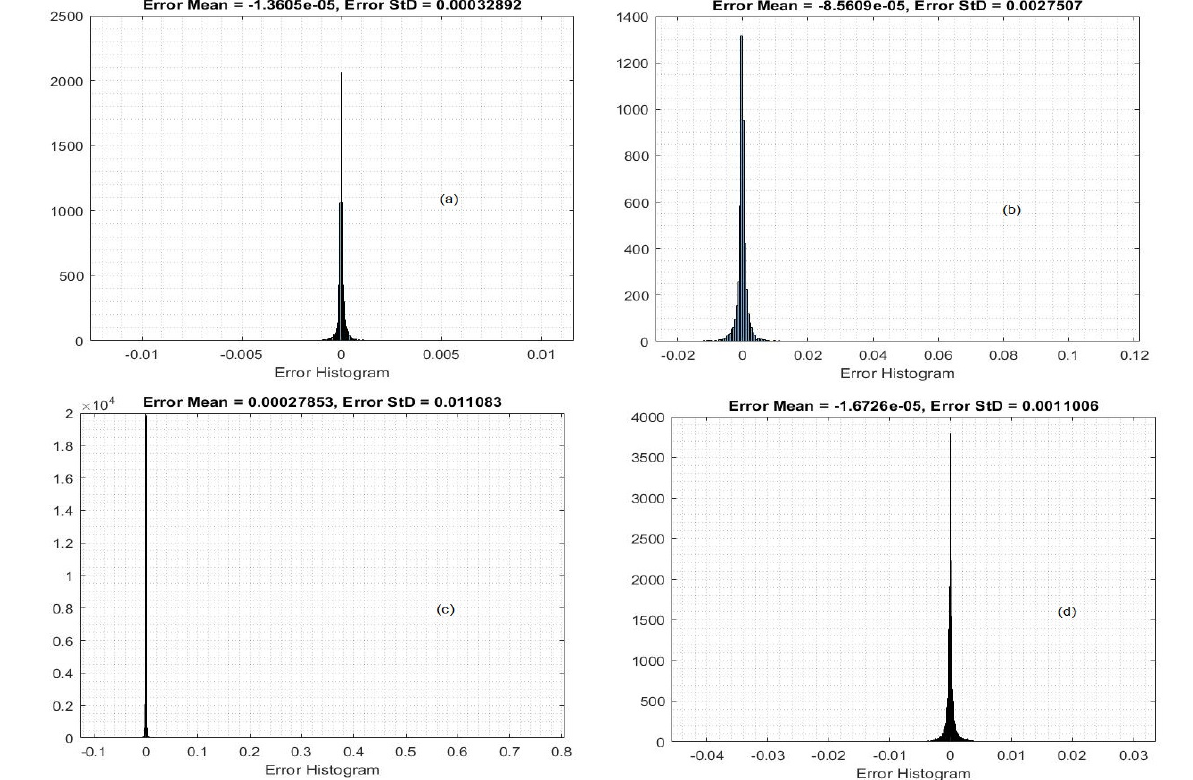
Figure 9. Histogram error of LSTM in training and testing ( a ) communication ( b ) energy, ( c ) financial and ( d ) industrial sectors.